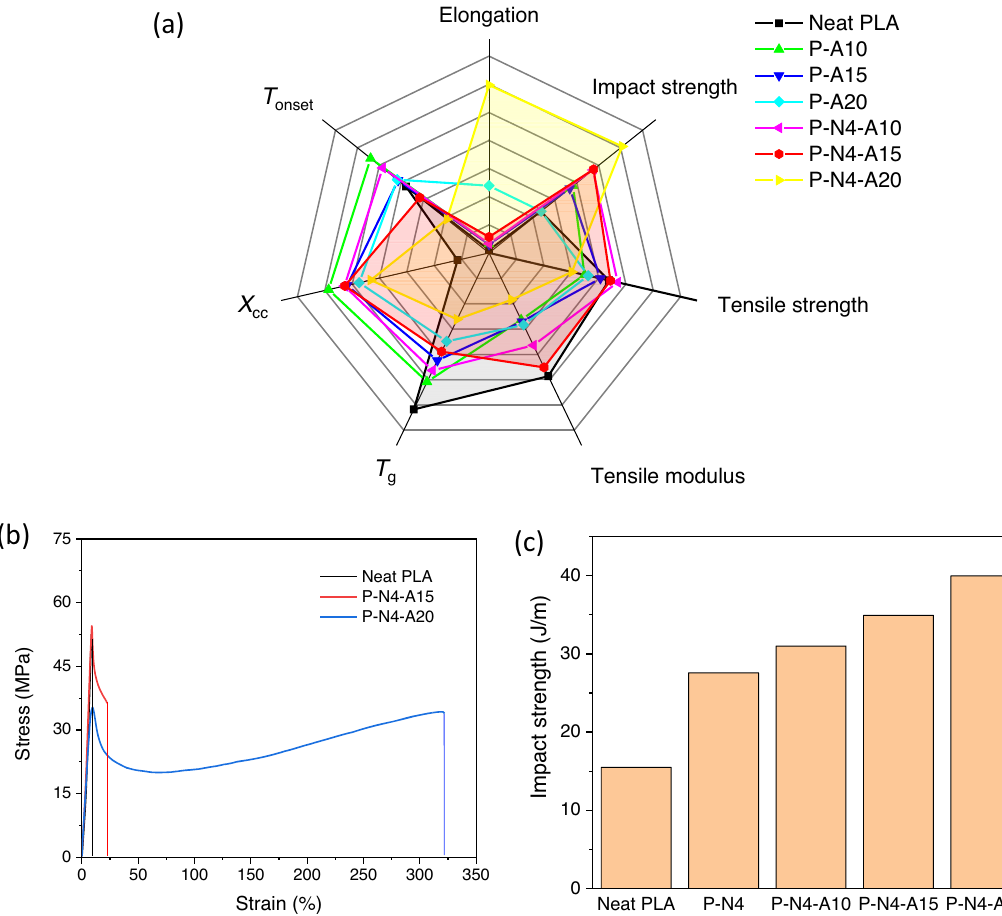
Figure 7: ( a ) A radar plot showing a comparison among the neat PLA, PLA/ATBC composites, and PLA/NFC/ATBC composites ( P: poly ( lactic acid ) ; N: nano fi brillated cellulose; A: acetyl tributyl citrate; and the numbers indicate the weight% ) [ 22 ] . The results are normalized to the range of 0 – 7. ( b ) Typical strain - stress of the neat PLA and PLA/NFC/ATBC composites. ( c ) Comparison of the impact strength of the PLA composites [ 22 ]